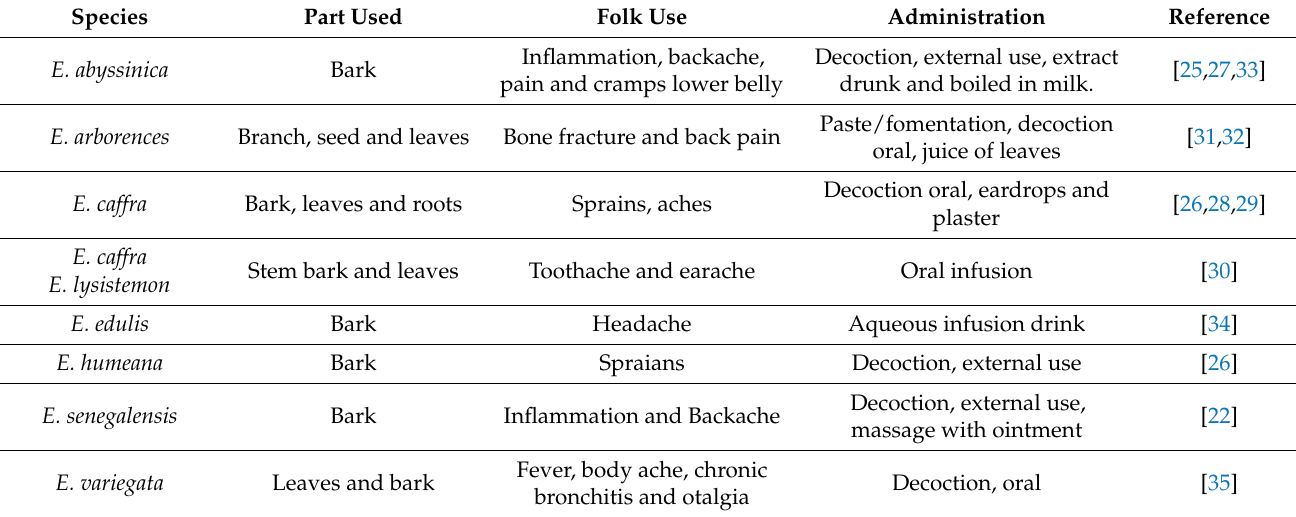
Table 1. Species of the genus Erythrina used in traditional medicine for the relief of pain or